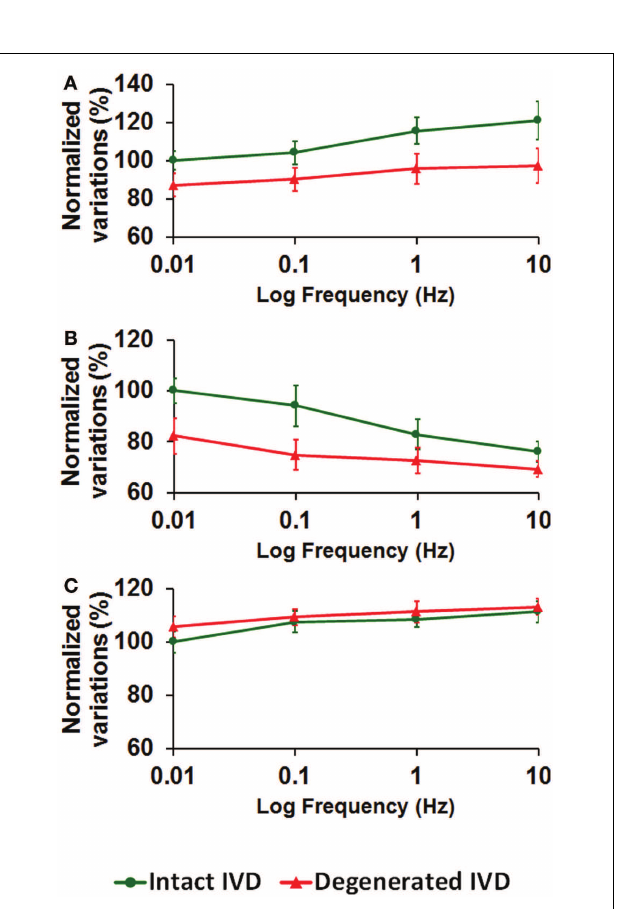
FIGURE 2 | Comparison of disk deformation obtained from in vitro cyclic loading experiments and the ones predicted by poroelastic FE model for (A) intact and (B) enzyme-induced degenerative intervertebral disks . Table 2 | Comparison of elastic modulus and hydraulic permeability between intact and enzyme-induced degenerative porcine intervertebral disks .